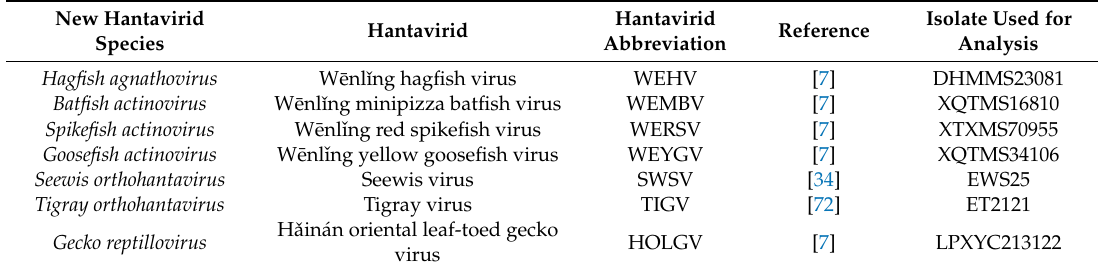
Table 2. New hantavirid species according to the 2019 ICTV taxonomy